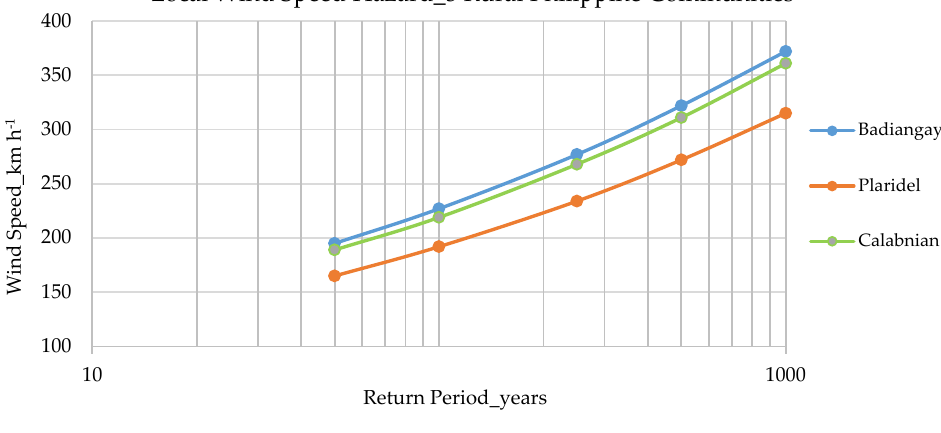
Figure 9. Wind speed hazard curve derived from [22].